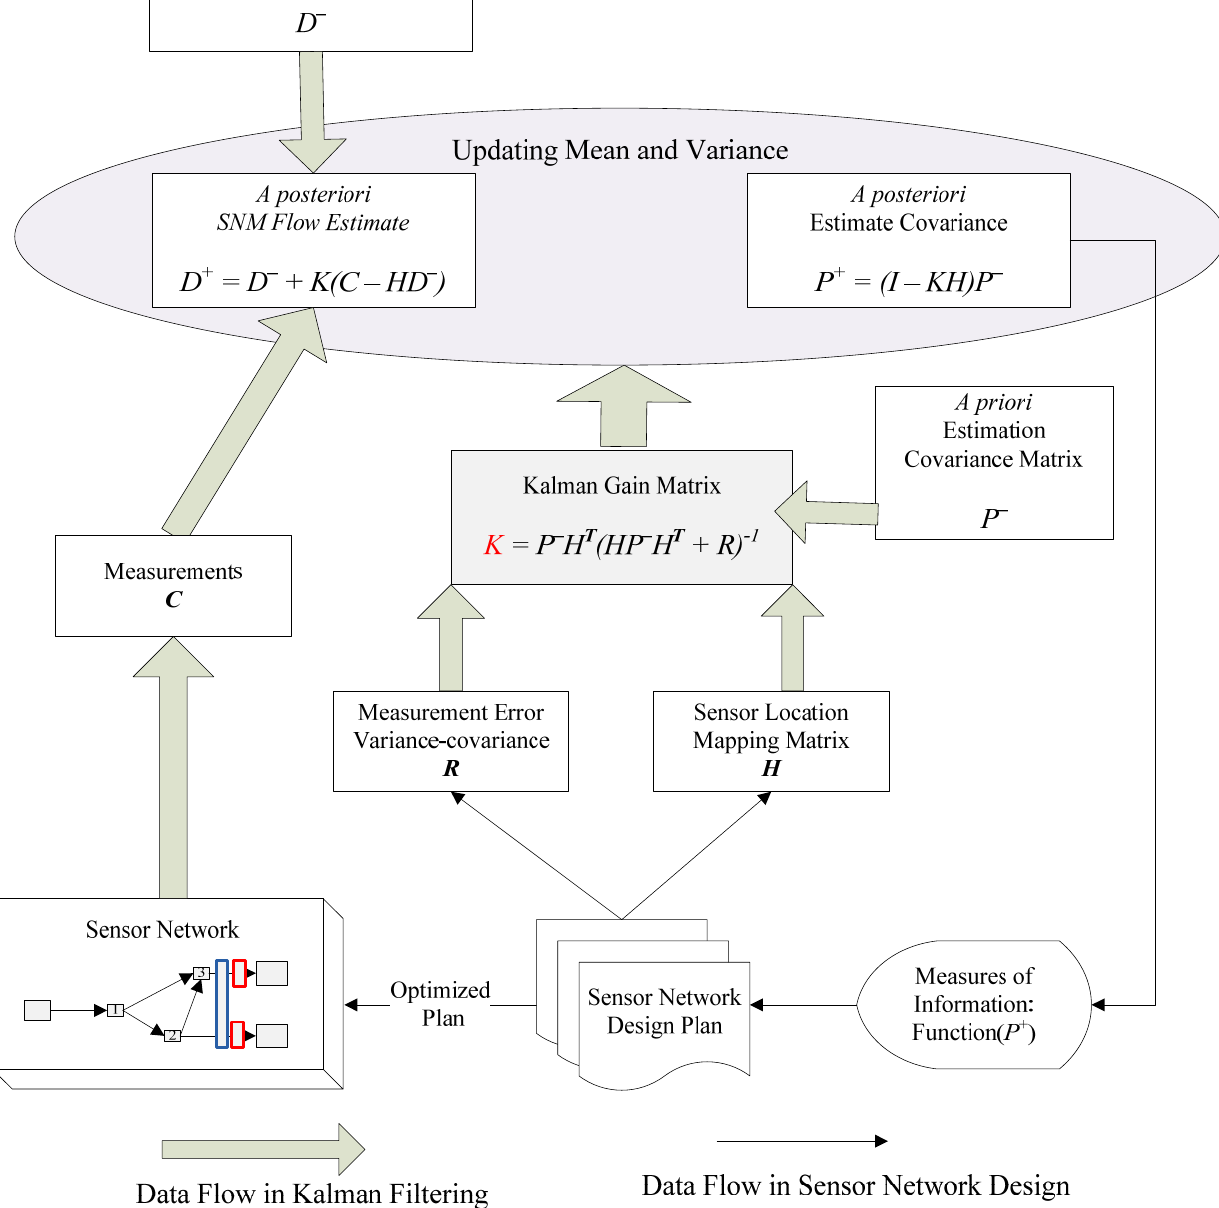
Figure 1. Data flow in Kalman filtering and sensor network design